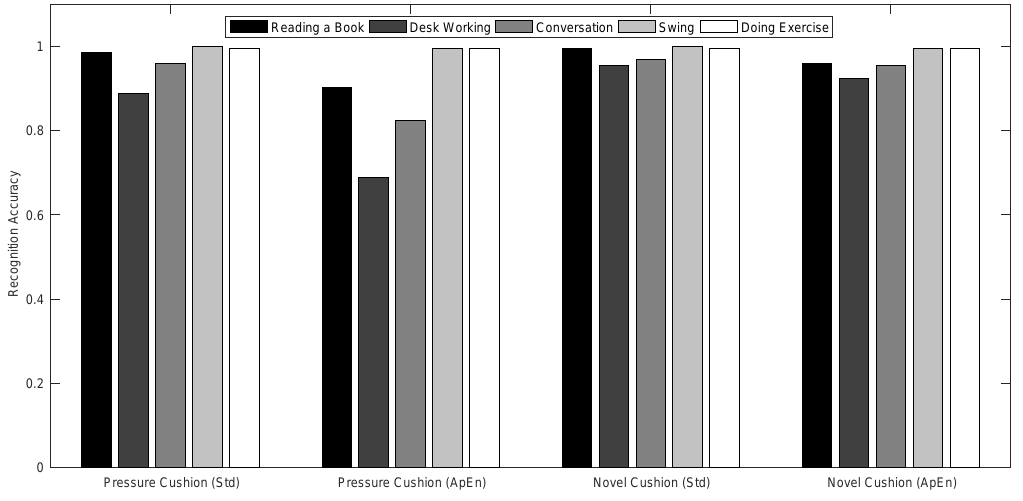
Figure 7. Recognition results for different activities.